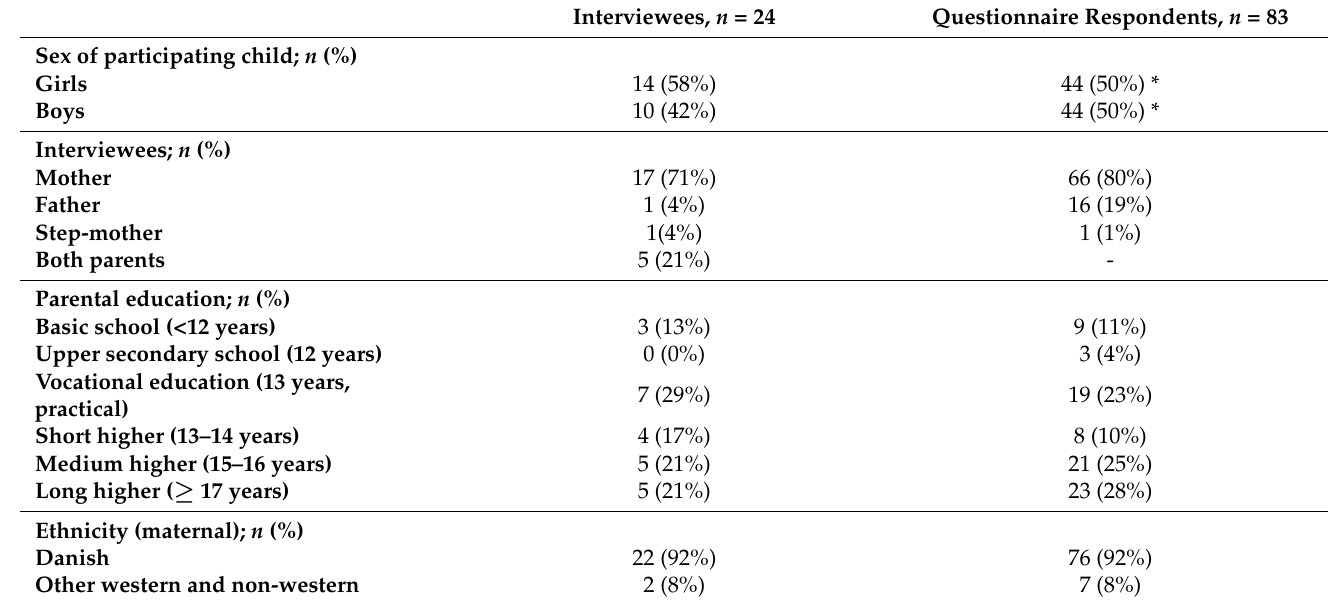
Table 1. Characteristics of the interviewees in the evaluation interviews compared with the question- naire respondents, which equals the total intervention